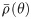
Simulations of (2) with additional sinusoidal forcing.In the top panel, snapshots of the probability distribution are taken immediately preceding every third and fourth pulse for the 83 and 94 Hz DBS pulsing, respectively. When there is no DBS pulsing, snapshots are taken at the sinusoidal forcing frequency. As averaging the term associated with the sinusoidal forcing would suggest, we observe desynchronization into three and four clusters for pulsing at 94 and 83 Hz pulsing, respectively. When the DBS pulsing is turned off at t = 8 seconds, the system quickly settles to a synchronized state. The bottom panels show the probability density averaged over multiple snapshots ρ¯(θ) after the initial transient has decayed. Horizontal dashed lines denote troughs of the probability distributions. The probability contained between successive troughs is 0.32, 0.35, and 0.33 in the left panels, and 0.26, 0.26, 0.25, and 0.23 in the right panels.